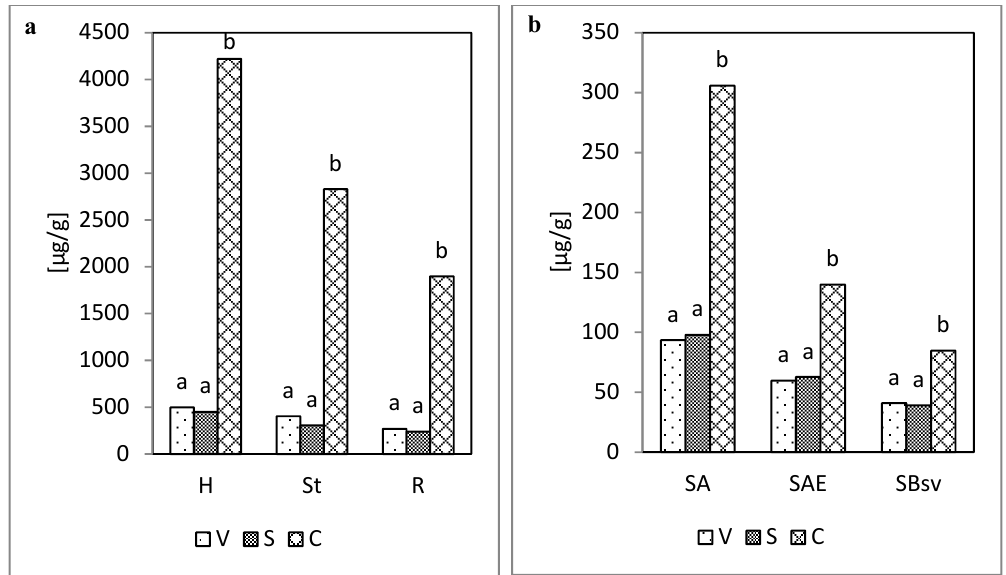
Figure 3. Content of vanillyl (V), syringyl (S), and cinnamyl (C) compounds following both hydrolyses (acid and alkaline): ( a ) in the plant material (H, St, R), ( b ) in soil (SA, SAE, SBsv).